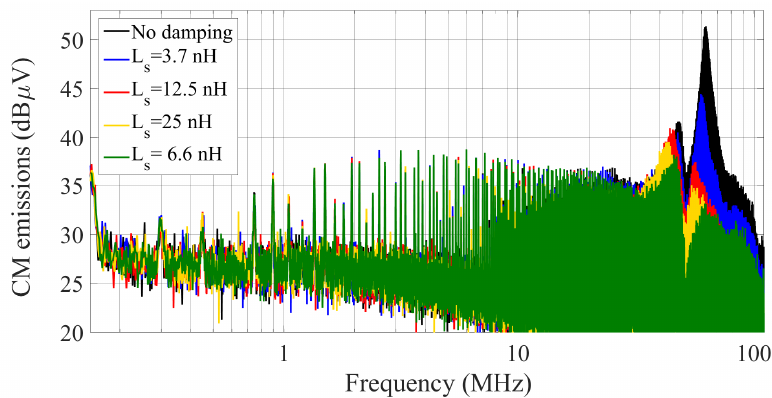
Figure 15. Measured CM of the designed Buck converter with 3 A output current, no damping and different values (3.7,6.6,12.5,25nH) of the source inductance. The 6.6nH value corresponds to the optimal